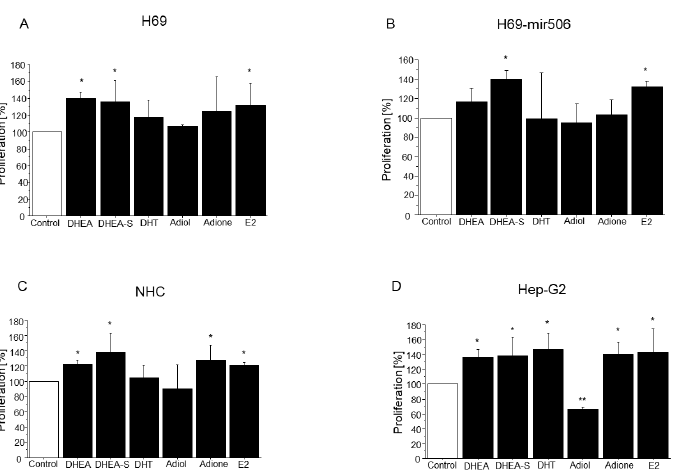
Figure 1. The effect of DHEA and its metabolites on the proliferation of cholangiocytes (H69, H69- miR506, and NHC) and hepatocytes (Hep-G2). Different cells types i.e., cholangiocytes ( A – C ) and hepatocytes ( D ) were incubated with DHEA and its metabolites (DHEA-S, DHT, adiol, adione and E2). Cells were harvested 48 h after treatment by scraping and were counted using CytoFLEX LX flow cytometer. Acquisition time was 60 s, and the sample flow rate was set at 60 μL/min. Results are presented as a mean ± SEM ( n = 3); * p < 0.05; ** p < 0.01.